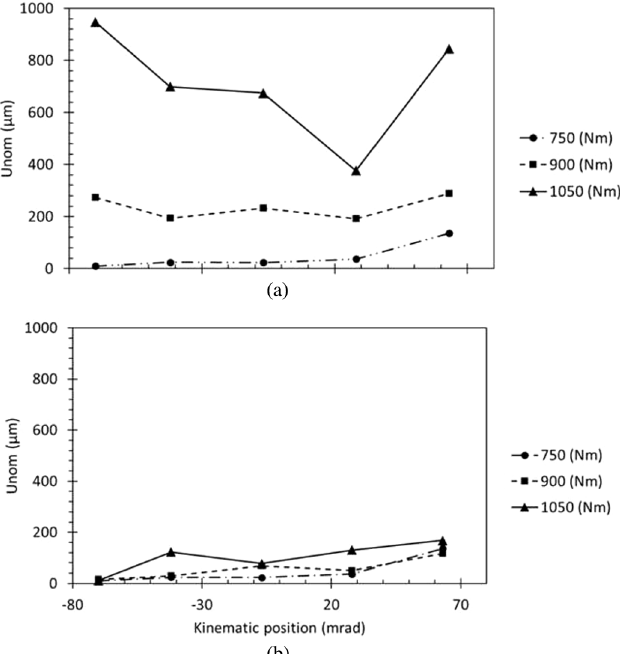
Fig. 12. Results of simulation of the total displacement on the worm and the wheel as a function of kinematic position for (a) the worm and (b) the wheel.